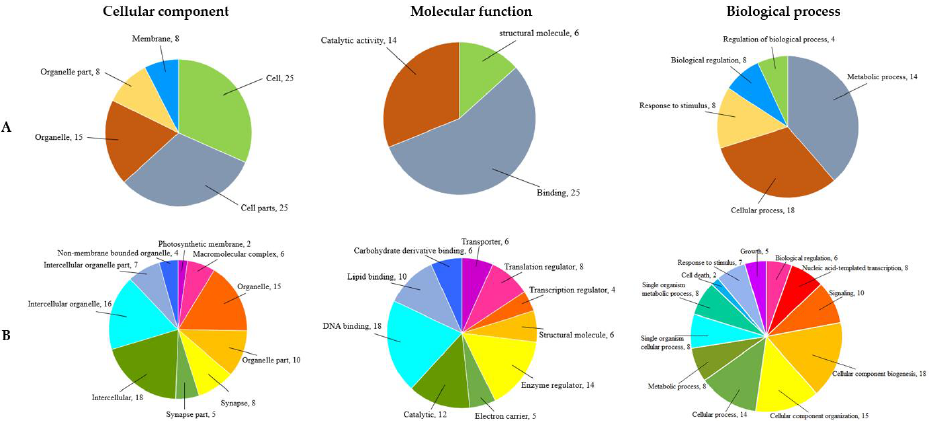
Figure 4. Level 2 ( A ) and level 3 ( B ) Gene Ontology classifications of the SNP-associated contig identified from ddRAD-sequencing.